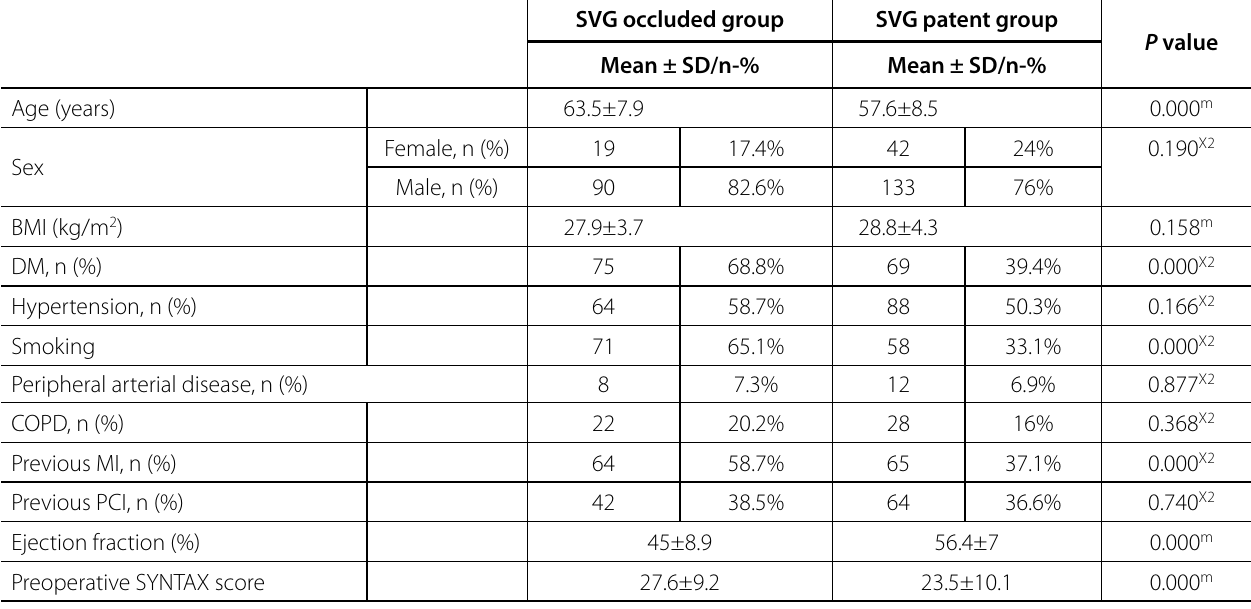
Table 1 . Patients’ basic clinical and laboratory